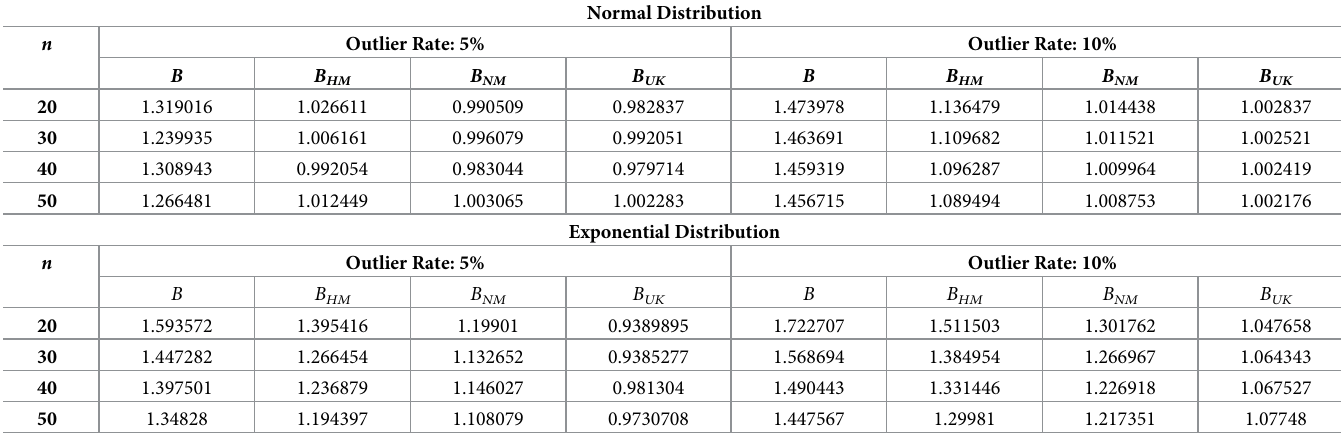
Table 6. B coefficients for M-Estimators under different distributions, rate of outliers and sample